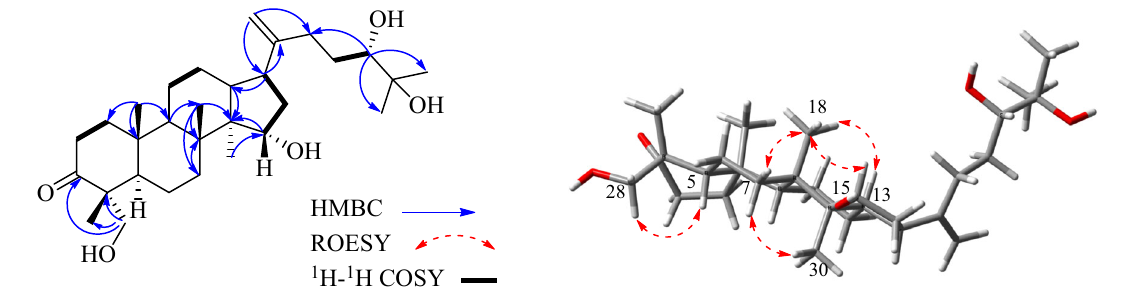
Fig. 2 The key HMBC, ROESY and 1 H- 1 H COSY correlations of compound